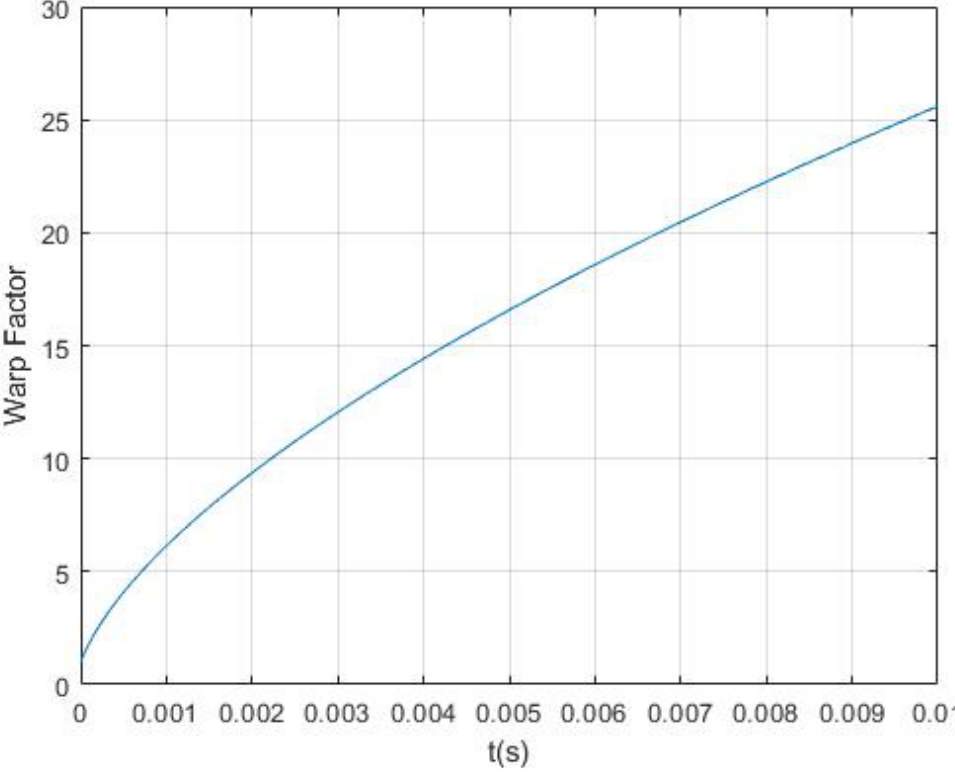
Figure 1. Warp factor for a t 2 perturbation with an equation of motion r ( t ) = h 0 + v 0 t